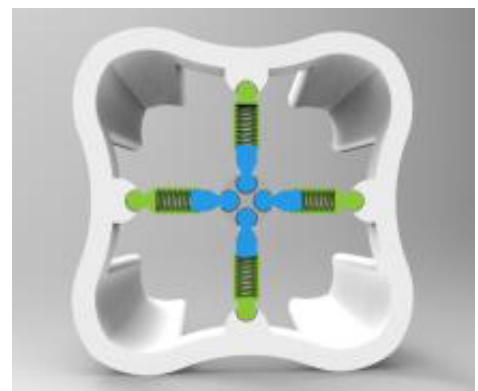
Figure 7. 3D model of the designed support mechanism consisted of a chain of segments with springs attached to the sides and a centre with 'ball-and-socket' joints